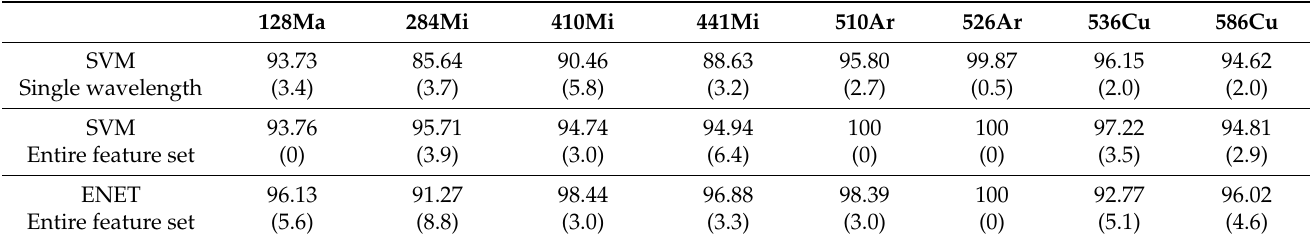
comparable to that of the hyperspectral ENET, the majority of wavelengths resulted in lower classification scores. The wavelengths represented by the bars highlighted in